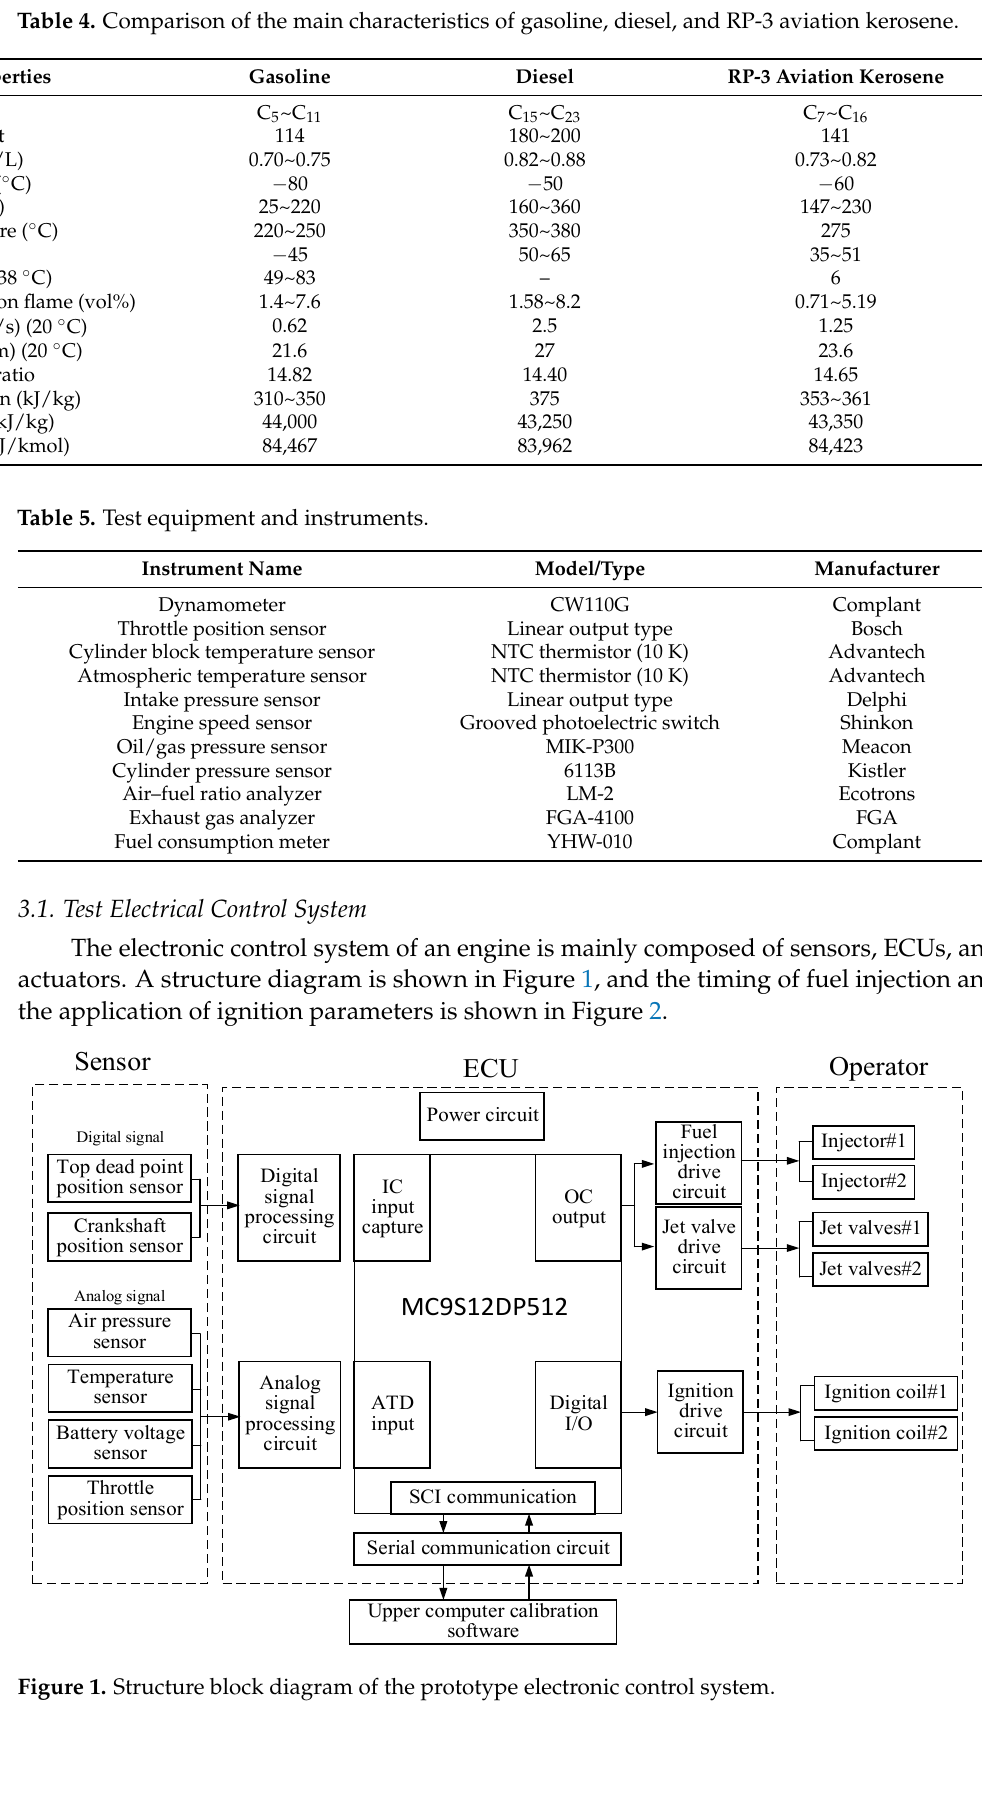
Figure 2. Timing diagram for the fuel injection and ignition parameters . The abbreviations in Figure 2 correspond to the following parameters: fuel pulse width, FPW; start of fuel injection, SOFI; end of fuel injection, EOFI; air pulse width, APW; start of air injection, SOAI; end of air injection, EOAI; charge pulse width, CPW. 3.1.1. Microcontroller The microcontroller is the core of the control system of a two-stroke, direct-injection engine. In this study, an MC9S12DP512 microcontroller with a 12-core CPU (Star Core) and 25 MHs bus speed is adopted. The advantages of this controller are a low clock fre- quency, high noise, and high vibration. The laboratory environment and the large memory can quickly realize complex mathematical operations to accurately control the parameters in the test. 3.1.2. Power Circuit The function of the power circuit is to provide a stable power supply to the ECU, sensors, and actuators. Figure 3 shows the power circuit.